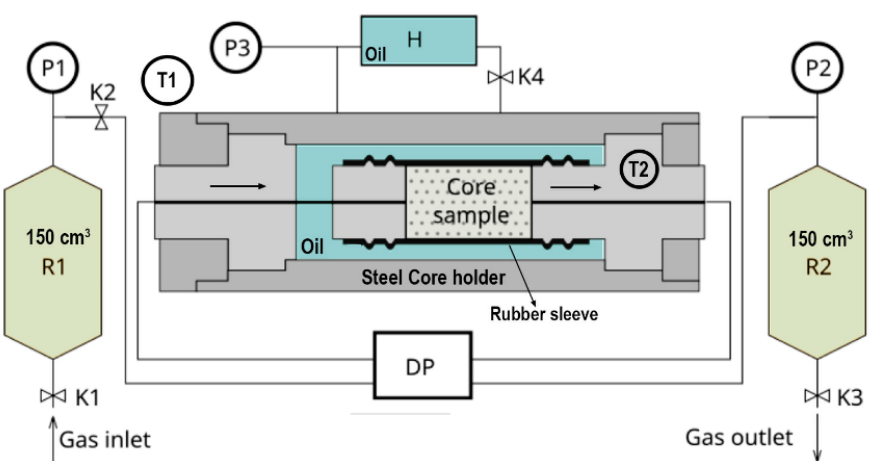
Figure 1. System for gas permeability measurements: K1 − K3 = diaphragm valves with pneumatic control, K4 = ball valve with pneumatic control, R1 − R2 = reservoirs with gas, P1 − P3 = pressure sensors, DP = differential pressure sensor, T1 − T2 = temperature sensors, H = hydraulic pump for confining stress.